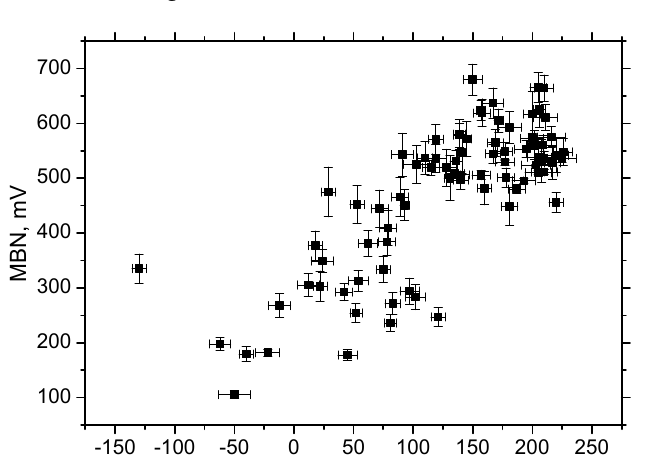
Figure 18. MBN versus HV0.5, RD.